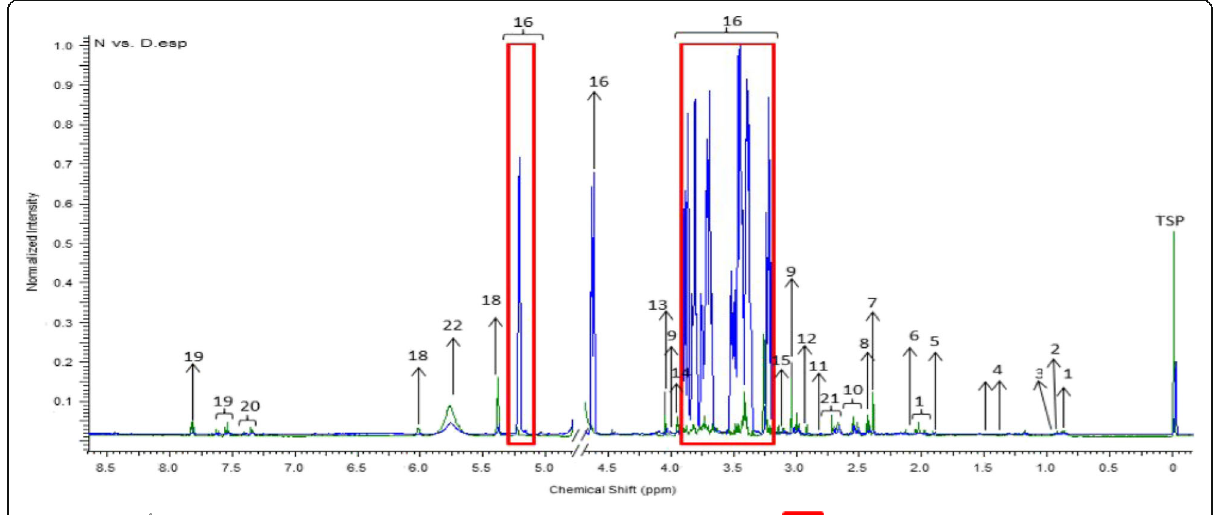
Fig. 1 Overlaid 1 H NMR spectra of normal and diabetic control rats ( Blue -Diabetes; Green -Normal, Sugar region). (1) Hydroxybutyrate (2)